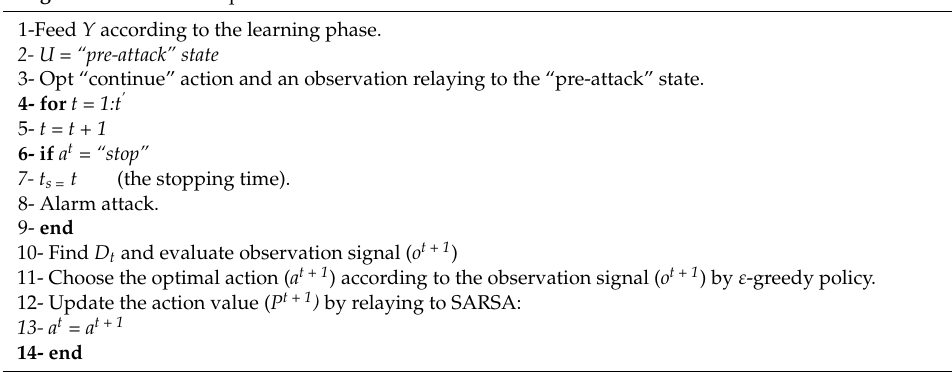
Algorithm 2: Detection phase